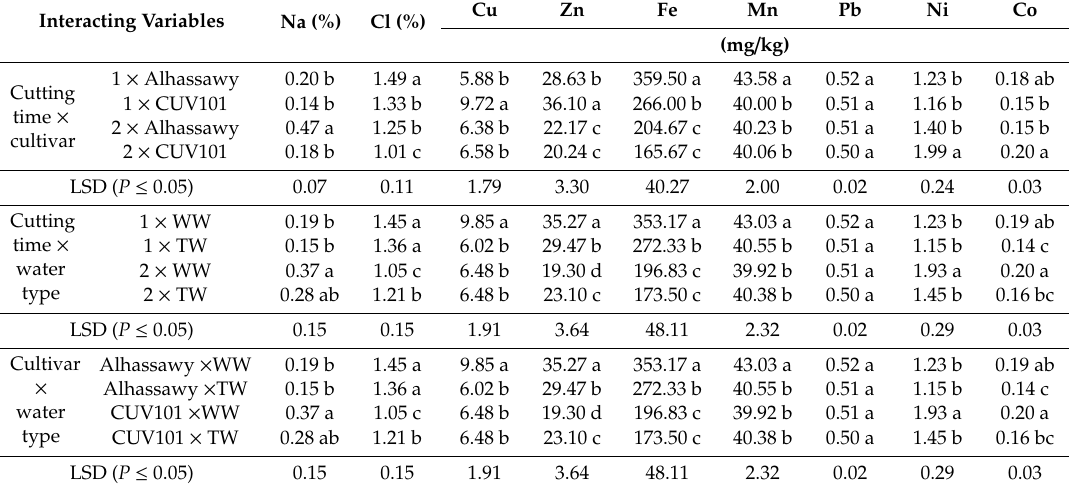
Table 6. E ff ects of the interactions between each pair of independent variables on alfalfa macronutrient